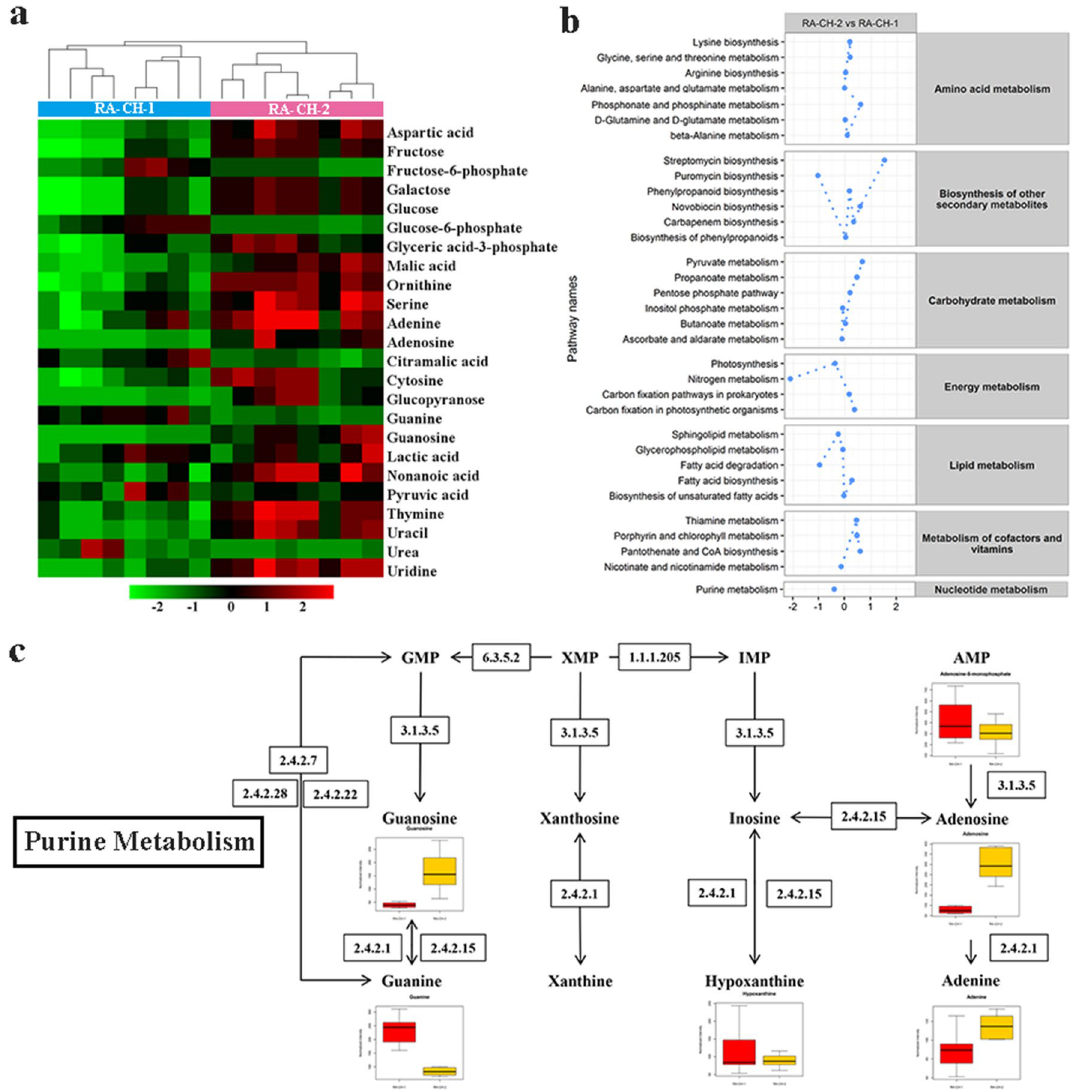
Figure 4. Comparison of network utilization in RA-CH-1 and RA-CH-2. ( a ) HAC of 24 biomarkers in two RA strains. RA-CH-1 (8 samples) and RA-CH-2 (8 samples) belonged to two subgroups. ( b ) Activities of RA metabolic pathways according to comparisons between two RA strains. The activity scores (AS) for each pathway were calculated using the PAPi algorithm. PAPi calculates an AS for each metabolic pathway listed in the KEGG database based on the number of metabolites identified from each pathway and their relative abundances. Related pathways are grouped according to their cellular metabolism and only pathways with statistically significant differences in activity (p < 0.05 by ANOVA) are shown. ( c ) The pathway of Purine metabolism in